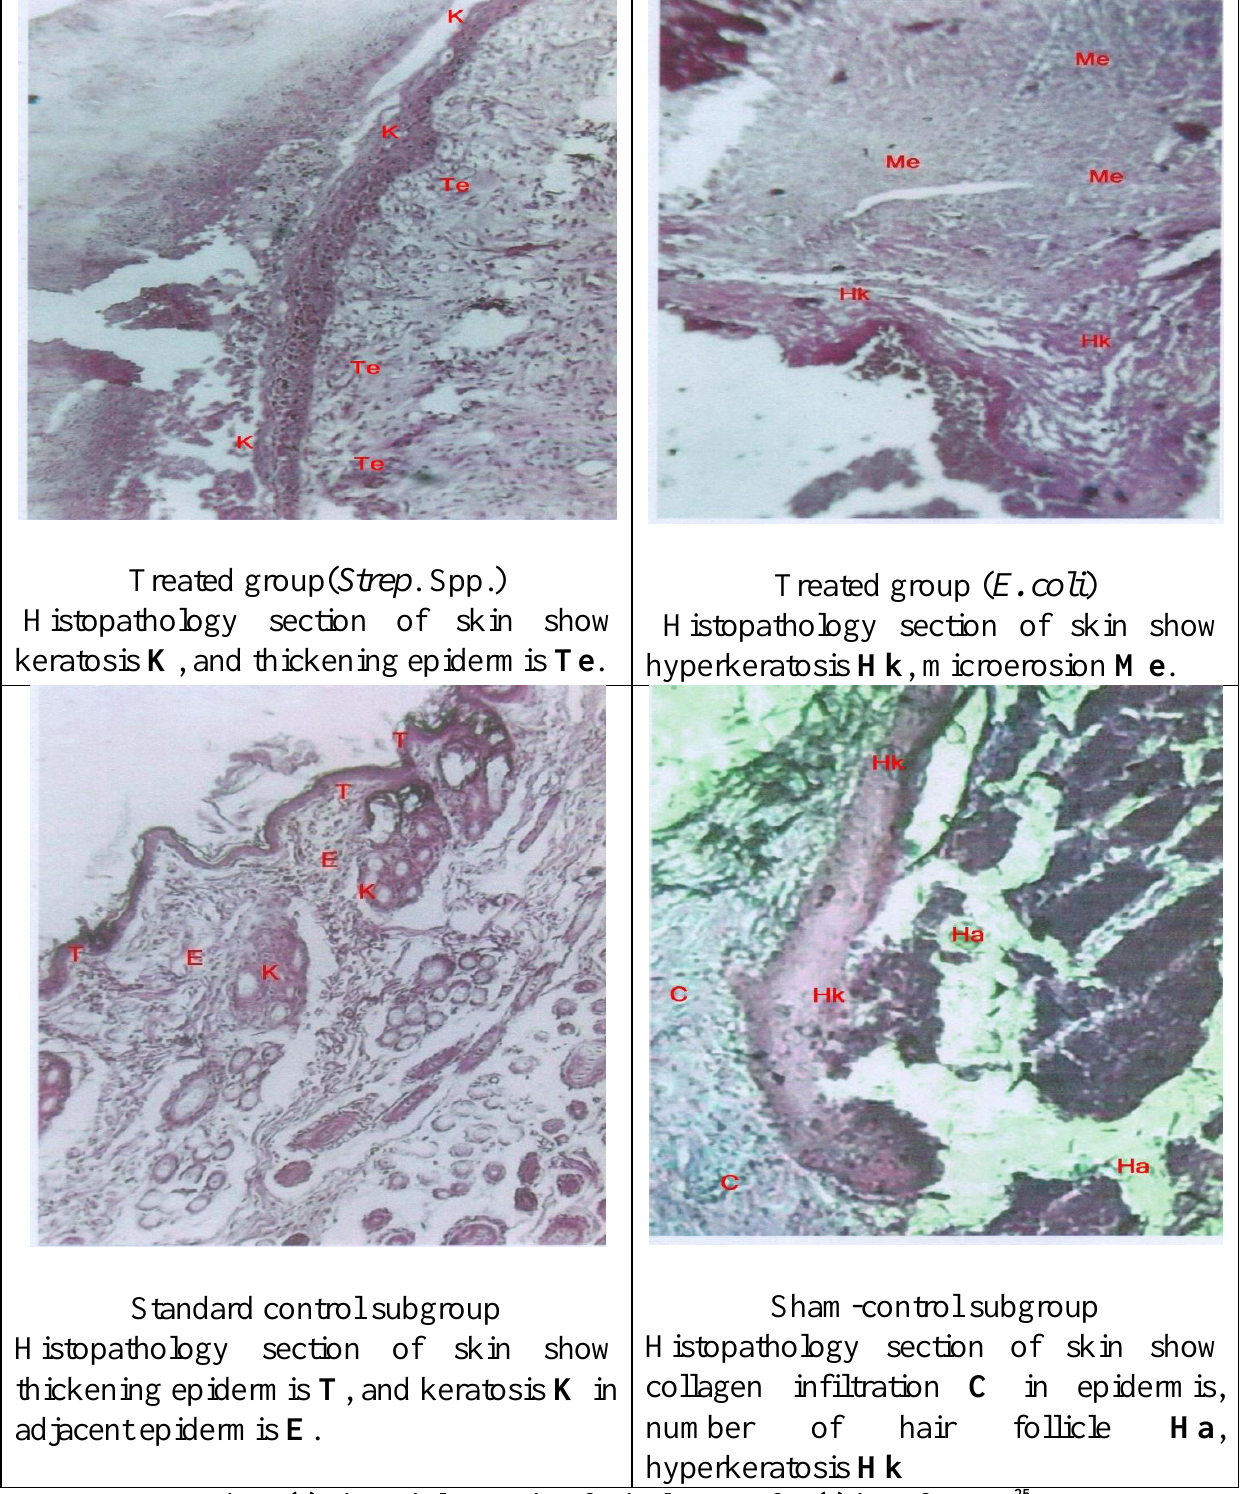
Figure (6) Histopathology section of animals group after (7) days of surgery